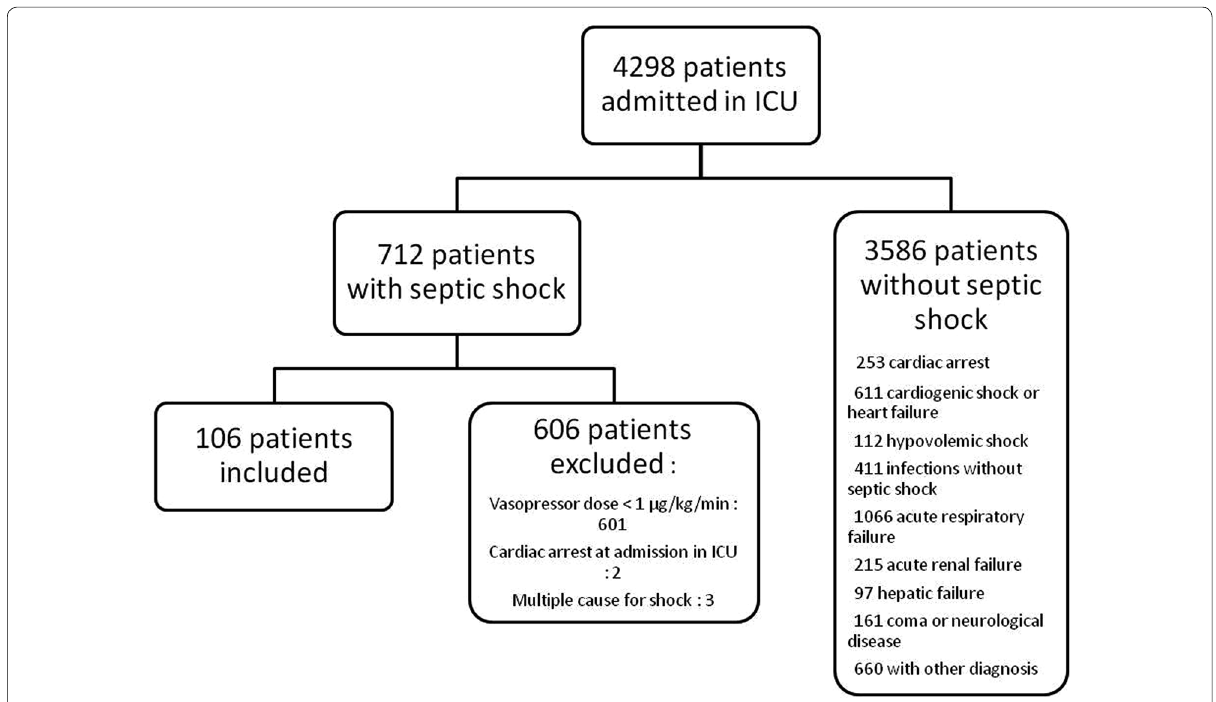
Table 1 General characteristics of the study patients at baseline Variables All ( n